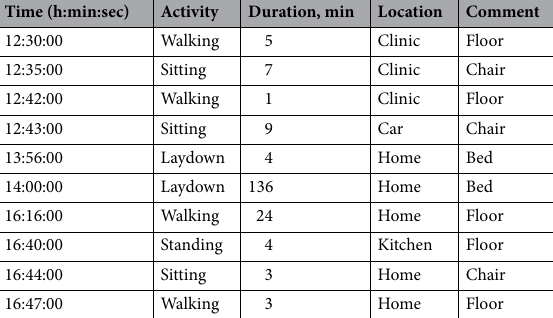
Table 2. Example of activities of daily living journal from a participant.